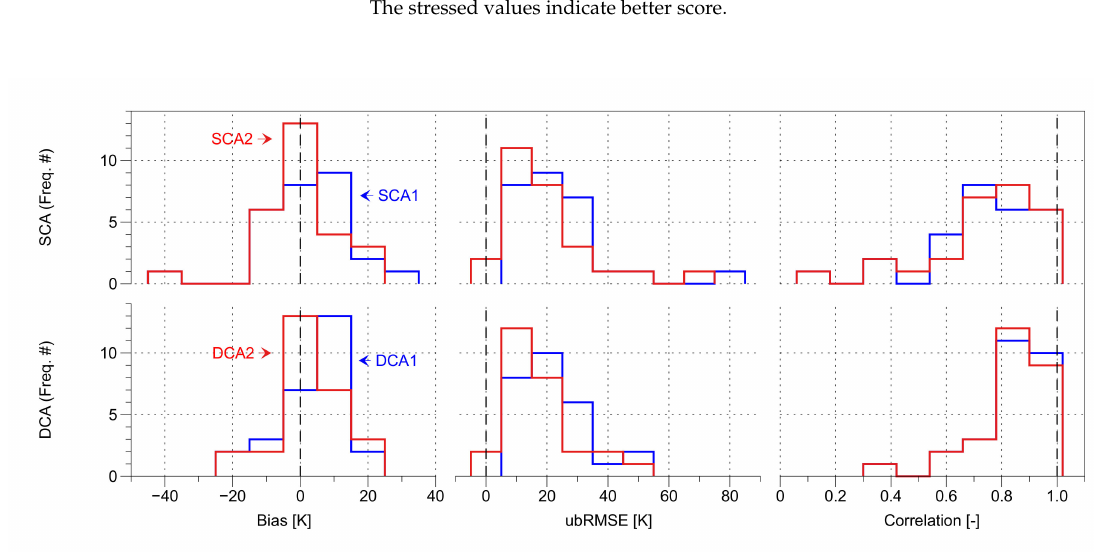
Figure 7. Histogram analysis of bias, ubRMSE and correlation for τ - ω (SCA1 and DCA1) and semi-empirical τ - ω (SCA2 and